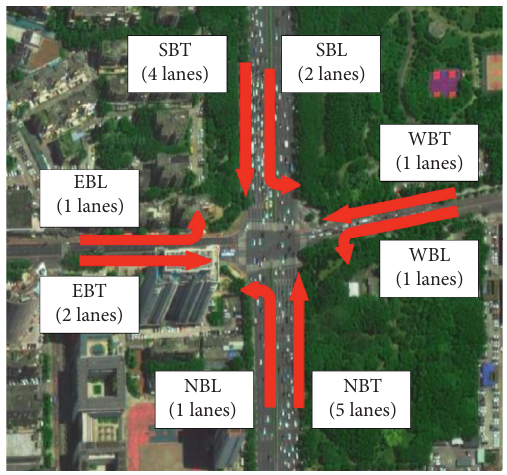
Figure 5: Layout of Huanggang-Fuzhong